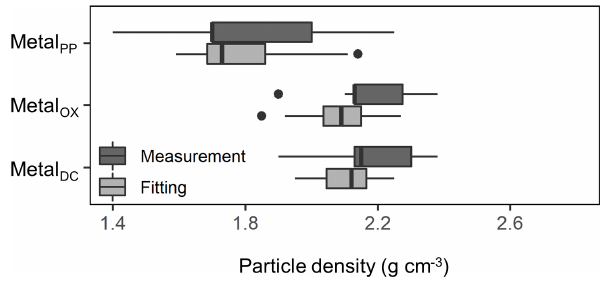
Figure 2. Boxplot showing the median and variation of densities at which the concentration of pedogenic metal (Al + 0.5Fe) was the highest across the 23 studied soils. The peak density was deter- mined for all three extractions (PP, OX, and DC) for each soil based on measurements (light color) and normal distribution fitting (dark